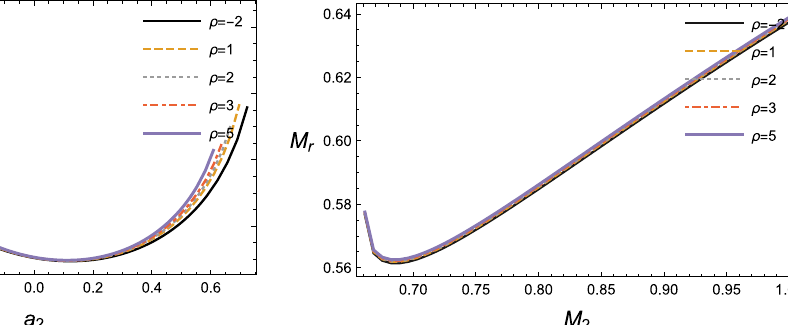
(b) The bounds on the radiation for g = 0 . 7, M 1 = 1, a 1 = 0 . 35, and a 2 = 0.